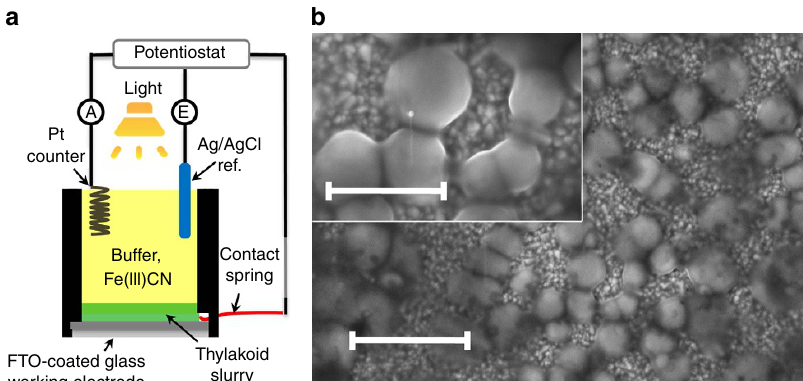
Figure 1 | The BPEC cell. ( a ) Schematic illustration of the BPEC cell. The cell comprises a cylindrical container with a window at the bottom, where a transparent working electrode (FTO coated glass) serving as the anode is sealed against a rubber gasket. The anode is electrically connected through a contact spring to a potentiostat, which is set in three-electrode mode (except for the two-electrode measurements described towards the end of the article), along with an Ag/AgCl reference electrode and a Pt counter electrode (that is, cathode). The potentiostat measures the current between the working and counter electrodes using an ammeter {A}, and the potential {E} of the working electrode with respect to that of the reference electrode. A minimal amount of thylakoids settles from a slurry of crude spinach thylakoids in buffer solution containing glycerol onto the exposed area (1.08cm 2 ) of the FTO anode. The cell cavity is filled with 20ml buffer A solution, containing the redox mediator Fe(III)CN (K 3 Fe(CN) 6 ), which serves as a recyclable electron shuttle between the thylakoids and the anode. ( b ) Scanning electron microscopy image of the spinach membranes on the surface of a FTO coated glass electrode. Small amount of membranes were placed on the electrode and the scanning electron microscopy images were taken in vacuum. Scale bar, 2 m m. Inset: scanning electron microscopy image at higher magnification. Scale bar, 1 m m.